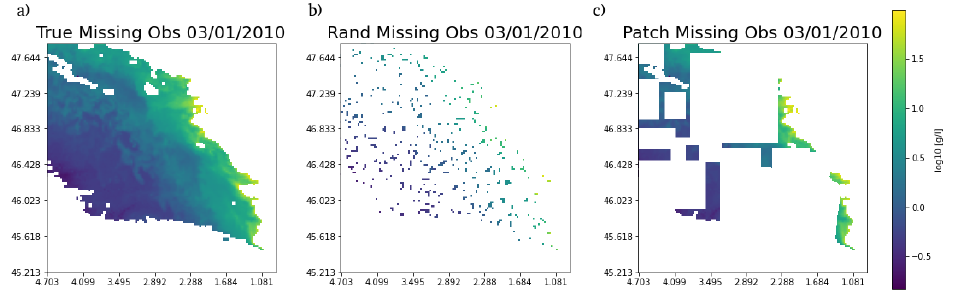
Figure 3. Different sampling strategy for validation by using missing observations: ( a ) True observa- tion from MODIS L2 image dataset ( b ) Random points sampling strategy for observation sampling ( c ) Patch sampling strategy for observation